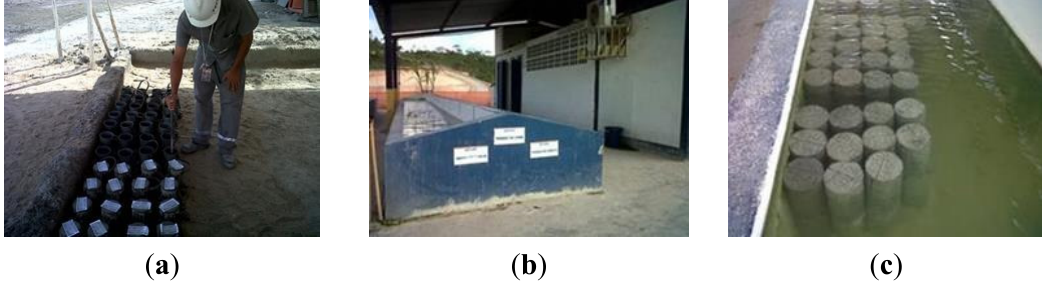
Figure 2. Cure of the samples at laboratory conditions. ( a ) specimen’s casting; ( b ) curing tank; ( c ) specimens immersed in the curing